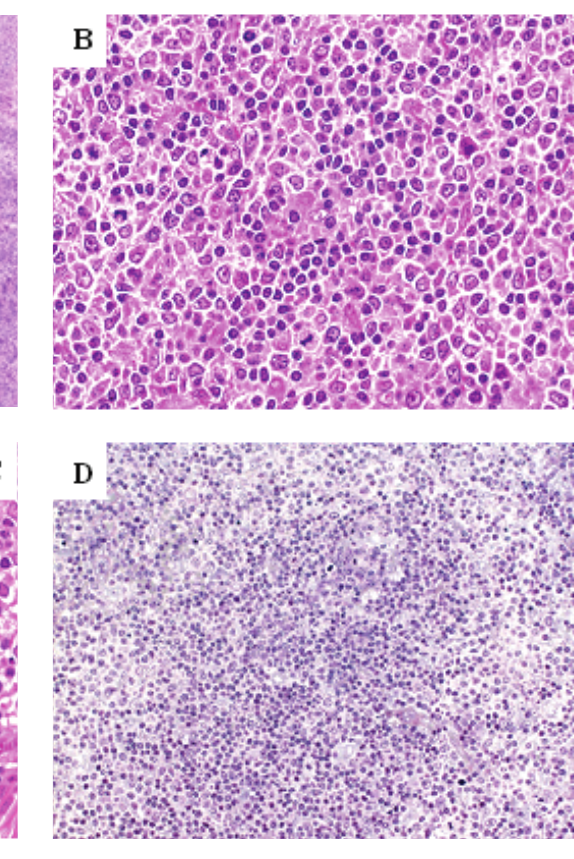
Figure 2: Representative micrographs of nodal marginal zone lymphoma (nMZL): A) typical growth pattern of a nMZL (over- view H&E staining), B) nMZL showing medium-sized slightly irregularly-shaped tumour cells with features of plasmacy- toid differentiation next to sparsely intermingled tumour blasts (high power magnification; H&E staining), C) nMZL displaying a blastoid cytomorphology together with more numerously intermingled tumour blasts (high power magnifi- cation; H&E staining), D) nMZL displaying the feature of sec- ondary follicular colonisation (low power magnification; Giemsa staining) in contrast to follicular lymphoma (FL) in fig. 2E, E) low-grade FL with prominent marginal zone B-cell dif- ferentiation (low power magnification; Giemsa